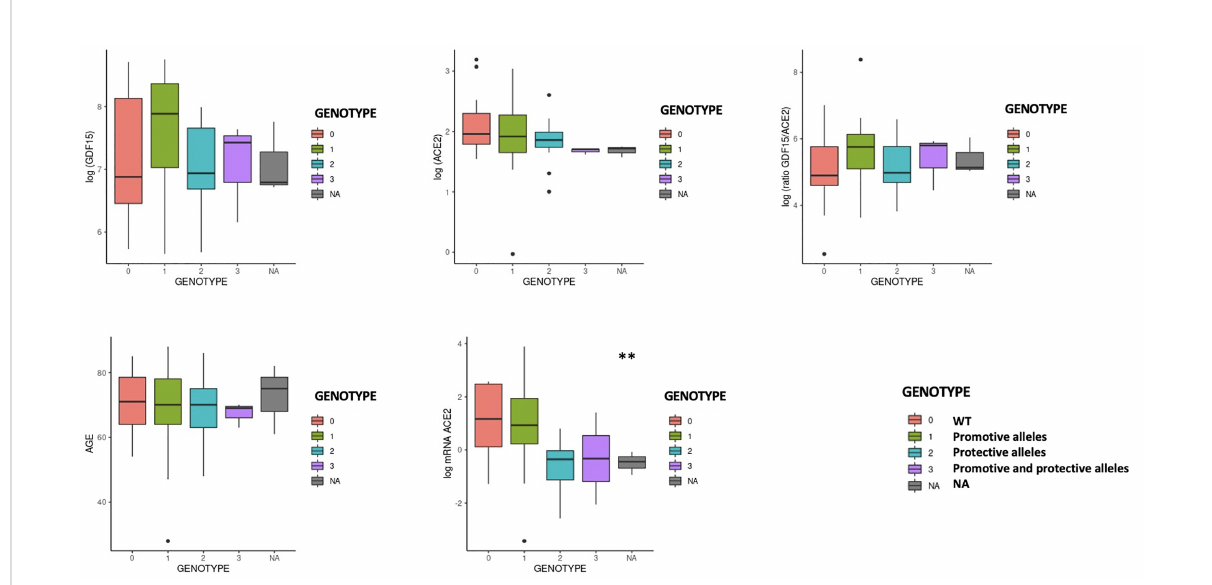
FIGURE 13 GDF15 and ACE2 levels by protective or promotive genotypes. Genotype 0 corresponding to subjects that did not carry any variant; Genotype 1, subjects that carry at least one promoting variant; Genotype 2, subjects that carry at least one protective variant; Genotype 3, subjects that carry at least one promoting and one protective variant (Supplementary Table 5; Figure 13). We only found differences in the levels of the ACE2 mRNA ( P